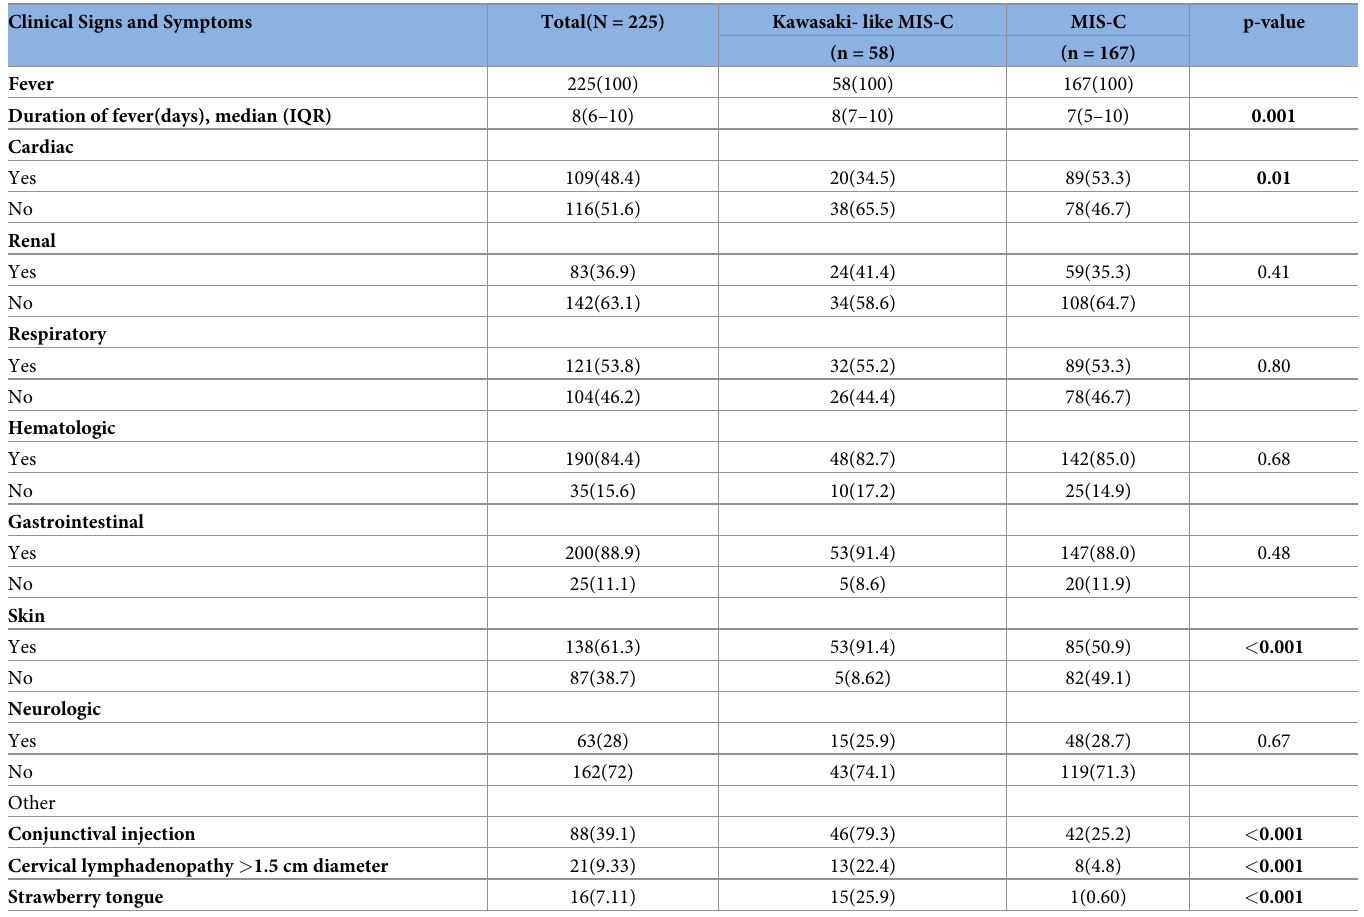
Table 2. Clinical signs and symptoms in Kawasaki- like MIS-C and MIS-C patients.